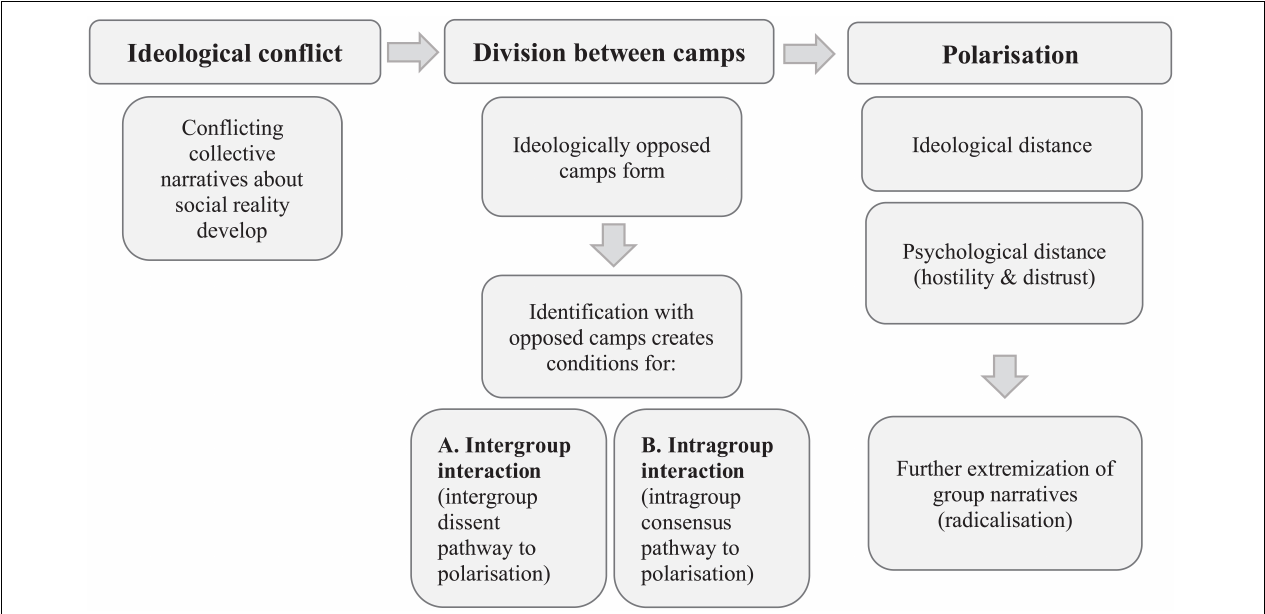
FIGURE 1 | Polarization, represented as a process initiated by the existence of conflicting narratives about social reality (ideological conflict), underpinned by division between members of opposed camps, and manifested as ideological and psychological distancing from the outgroup. Radicalization could occur as a result of further extremization of group